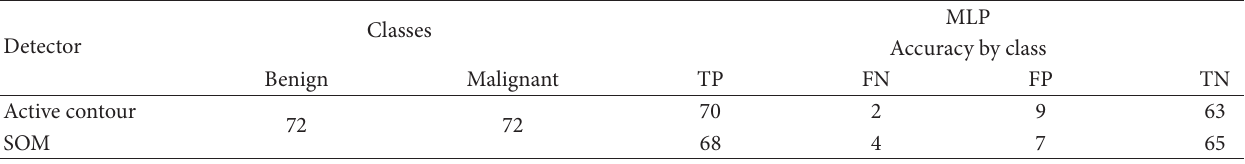
Figure 10: ROC curves obtained from the classification using MLP with US phantoms images. Segmentation by (a) SOM network and (b) active contour. Table 5: Evaluation metrics applied to ultrasound breast phantoms images.